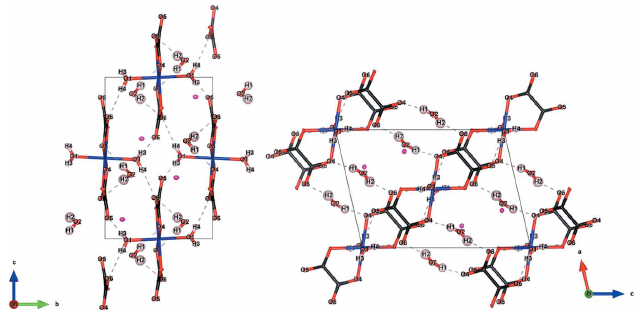
Figure 2 The hydrogen-bonding network of Rb 2 Co(C 2 O 4 ) 2 (cid:2) 2H 2 O (I) viewed along the a and b axes. Displacement ellipsoids are drawn at the 30% probability level. The hydrogen bonds are shown as dashed lines. Colour code: Rb (pink), Co (blue), C (black), O (red) and H (light pink).